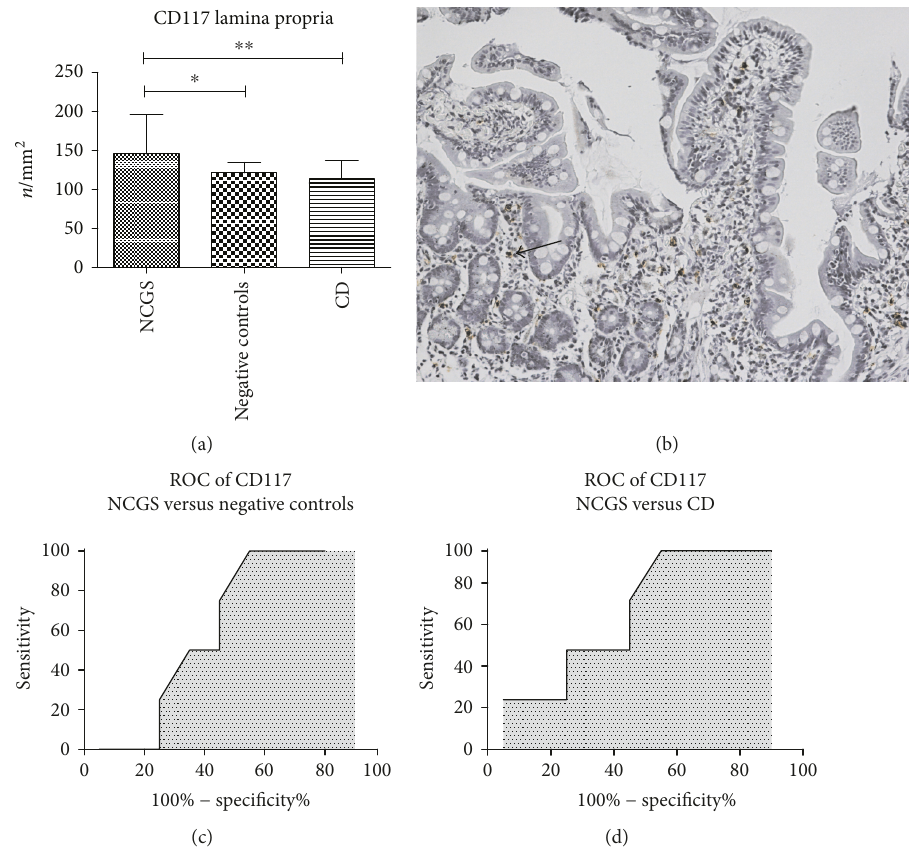
Figure 4: Immunohistochemical expression of CD117 in lamina propria (a). Bars and error bars represent mean and standard deviation, respectively. ∗ p < 0 05 and ∗∗ p < 0 01 . (b) An immunohistochemical picture of a patient with NCGS: positive cells are stained in brown, magni fi cation × 200. (c and d) ROC curves of sensitivity analysis of CD117 count as a discriminative factor between NCGS and celiac disease or normal controls. An arrow highlights positive